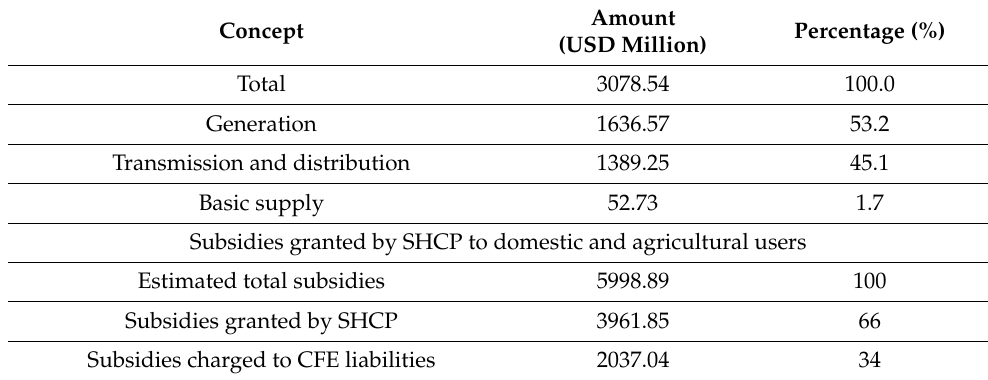
Table 5. Cost of CFE inefficiencies recognized by the CRE in electricity